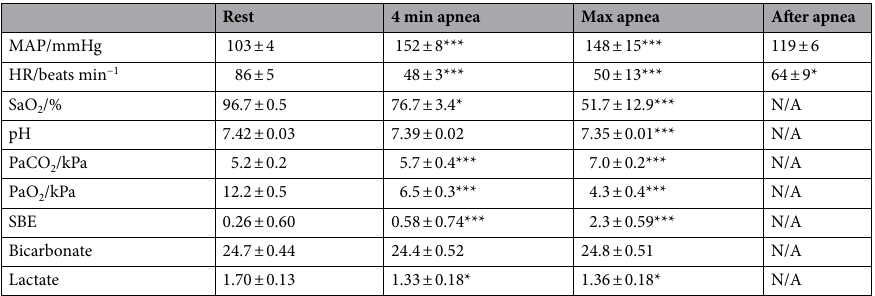
Table 2. Hemodynamic parameters and blood gas results at rest, after 4 min apnea and at end of apnea (326 ± 19 s). Values are means ± Standard Error of Means; * P < 0.05 versus rest and *** P < 0.001. MAP mean arterial pressure; HR heart rate; SBE standard base excess; SaO 2 arterial oxygen saturation; PaCO 2 partial pressure of carbondioxide;